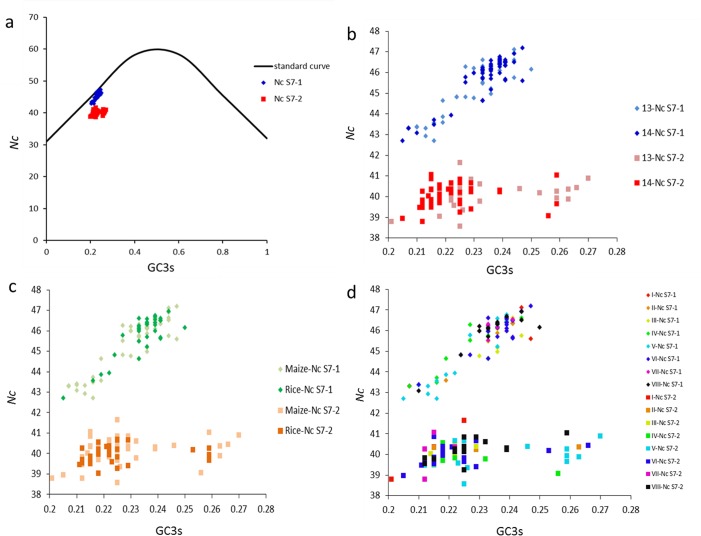
Distribution of effective number of codons (Nc) and GC3s in S7-1 and S7-2.(a) Distribution of Nc and GC3s in S7-1 and S7-2. The solid line (shown in black) indicates the standard Nc value if the codon bias is only due to GC3s. (b) Distribution of Nc and GC3s in S7-1 and S7-2 in data from two years. (c) Distribution of Nc and GC3s in S7-1 and S7-2 in two hosts. (d) Distribution of Nc and GC3s in S7-1 and S7-2 in eight geographic locations.